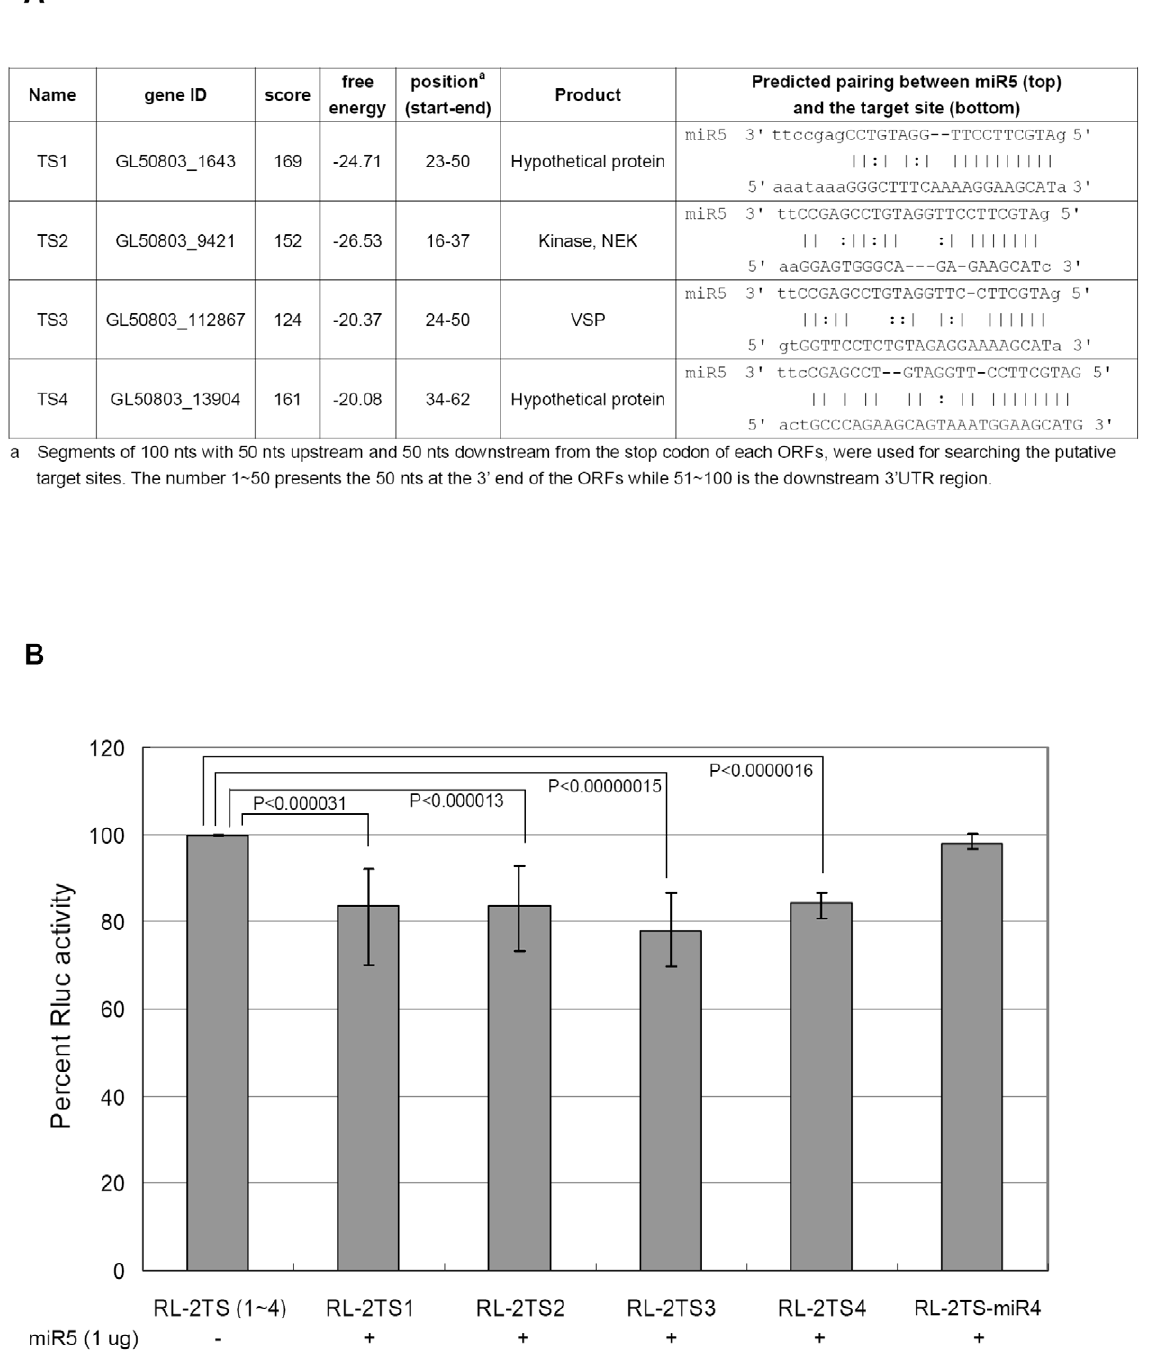
Figure 8. Experimental verification of potential target(s) for miR5. ( A ) The four genes containing potential miR5 target sites chosen for further test. ( B ) Two copies of each potential miR5 target site separated by a 10 nt spacer were cloned to the 3 9 -UTR of Rluc gene to generate four constructs: RL-2TS1, 2, 3 and 4. A Luciferase transcript carrying at the 3 9 -UTR a double miR4 target sites from another VSP (GL50803_36493) [21], unrelated to that of miR5, was included as a control (RL-2TS-miR4). The in vitro transcripts (4 m g) with or without 1 m g of synthetic miR5 were each introduced into Giardia via transfection and the subsequent Luciferase expression was monitored. The results and standard deviations were from three independent transfection experiments. The p-values indicated were calculated by two-tailed Student’s t -test. triphosphate structure [44]. The 2 9 -O-methylation at the 3 9 -end of RNA reduces also the efficiency of ligation by T4 RNA ligase by in Giardia , will not efficiently capture the small RNAs with a 5 9 - the standard cloning technique [48]. Recently, it was shown that